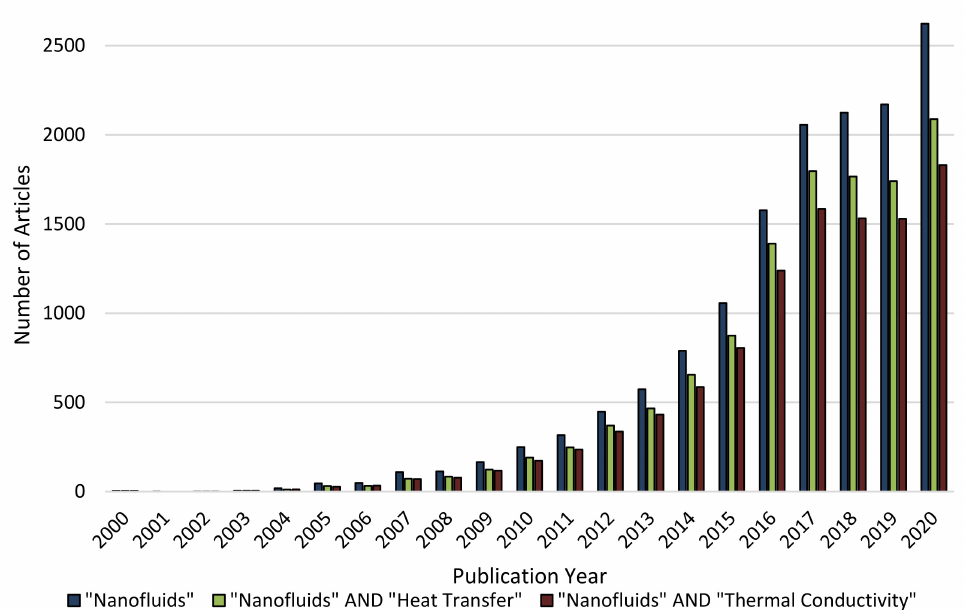
Figure 1. Number of scientific journal articles presented in the Science Direct database published between January of2000 and September of 2020.(Search date: 10.09.2020) (Please read the data availability